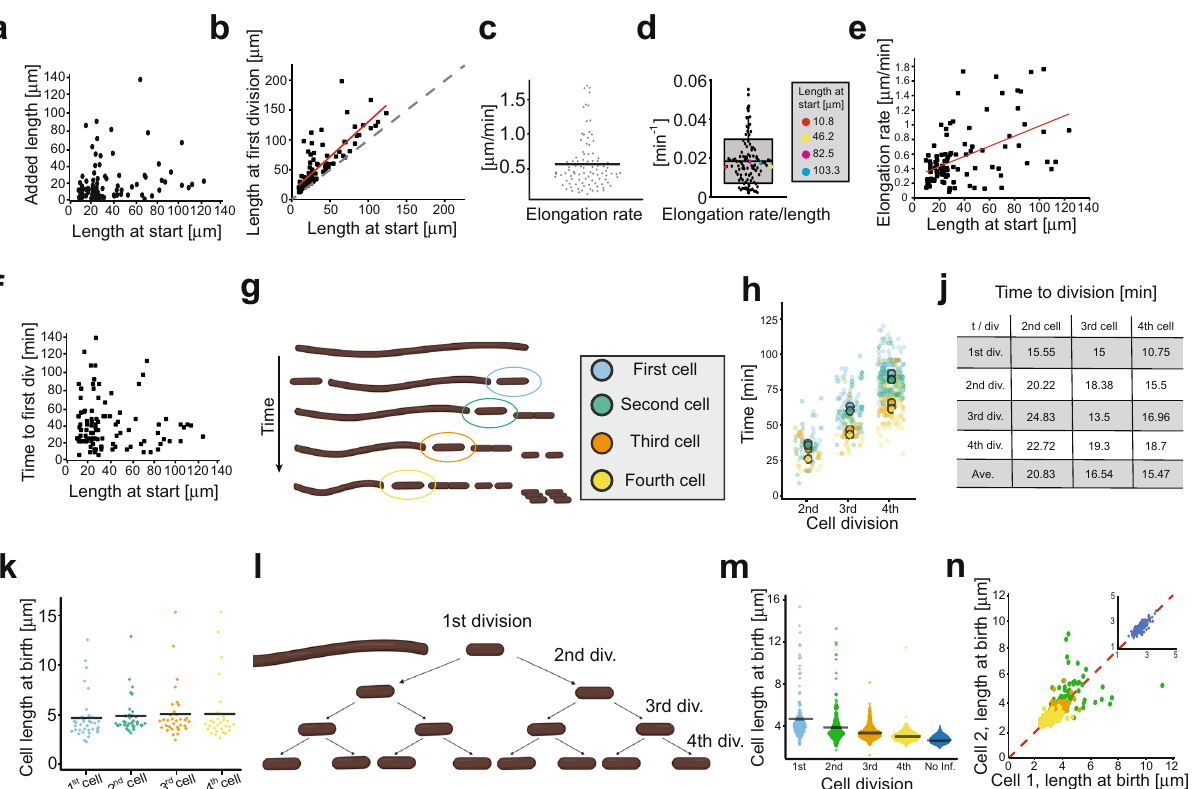
Fig. 2 Growth and division dynamics of UTI89 fi laments that revert to rods. a Added cell length from the start of imaging to the fi rst division (mean = 19.78±22.3 μ m, n = 101) vs cell length at the start. b Relationship between fi lament length at start and at fi rst division. The red line indicates a linear fi t to the data. Dotted line indicates no growth before fi rst division. c Variation in elongation rate between fi laments (between 0.08 and 1.76 μ mmin − 1 ). The mean elongation rate was Δ L/ Δ t = 0.55±0.4 μ mmin − 1 , n = 101. d Elongation rate (0.0187±0.0113min − 1 , n = 101) of fi laments normalized to their length at the start of the imaging. Box outlines indicate SD, midline indicates mean, whiskers indicate 95% interval. Data maxima and minima are 1.76 and 0.08min − 1 , respectively. Box to the right high-lights four randomly picked fi laments with rates close to mean (red = 0.015min − 1 , yellow = 0.0152min − 1 , magenta = 0.0178min − 1 , blue = 0.017min − 1 ),these fi lamentsrangedfrom10to100 μ m inlength,indicating weakcorrelationbetween lengthand elongationrate. e Theelongationratewas not correlated to the length of the fi laments at the start of imaging. The red line shows a linear fi t to the data. R 2 = 0.245. f No apparent correlation between fi lament length at the start of imaging and time to fi rst division was found. g Schematic representation of the fi rst to fourth generations of cells during fi lament division. h Timing of subsequent division events in ‘ mother ’ fi laments after birth of the newborn cells depicted in f (colour key). Larger circles represent the means ( n div = 471). j Mean inter-division times in subsequent divisions of the mother fi lament after the second, third, and fourth cells have pinched off. Overall means were: (cid:1) X 2 nd ¼ 20 : 83 ± 3 : 99min :; (cid:1) X 3 rd ¼ 16 : 54 ± 2 : 75min :; (cid:1) X 4 th ¼ 15 : 47 ± 3 : 41min : (average±S.D.) k Mean cell lengths of the smaller newborn cell pinched off from a fi lament ( n = 135). l Schematic representation of the subsequent division events of pinched-off newborns. m Lengths at birth of daughter cells from fi rst to fourth generations. n Symmetry of division in newborns. Second generation (green) cells divide more asymmetrically than third (orange) and fourth (yellow) generation of cells. Inset; UTI89 grown in LB divides highly symmetrically. All values represent mean±SD. Source data are provided as a Source data fi